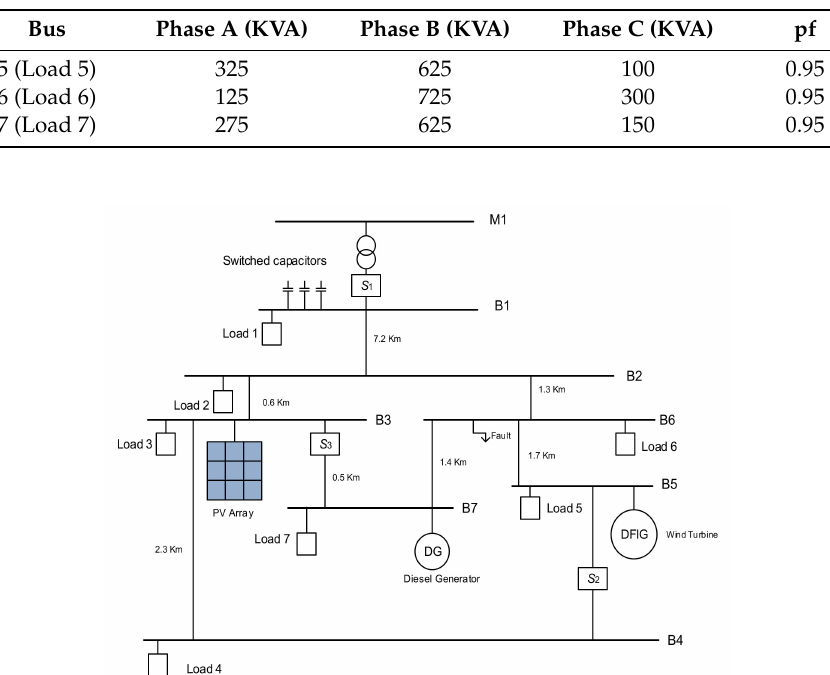
Table 2. Critical Load Data.